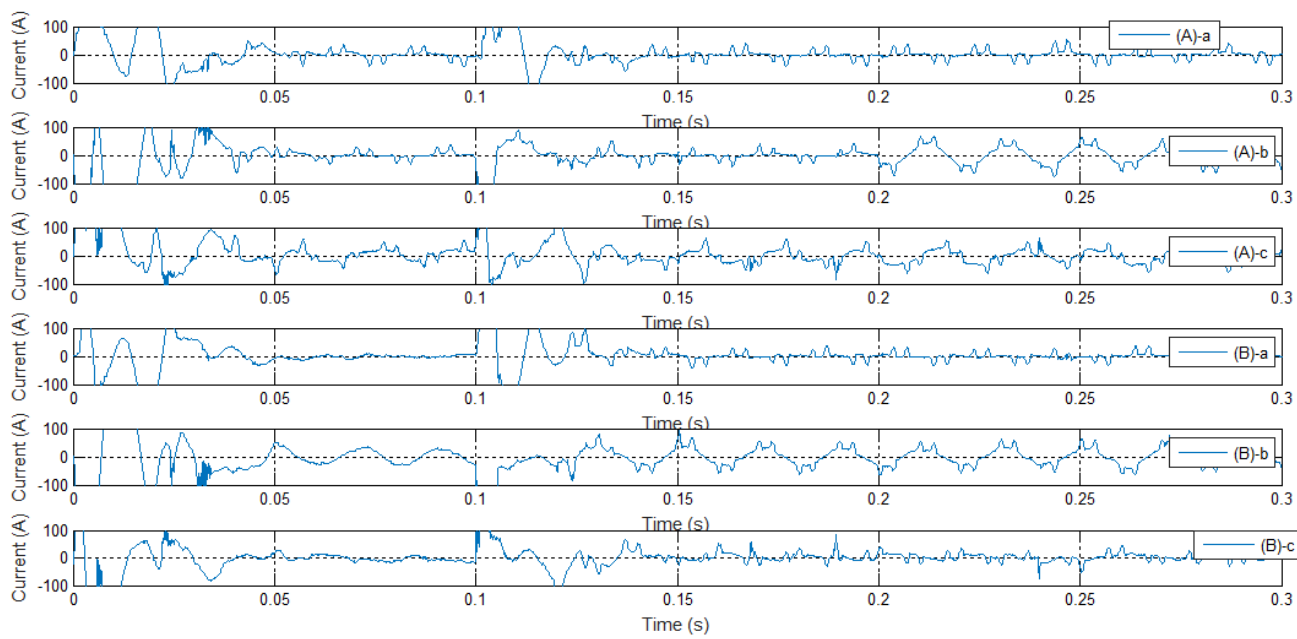
Figure 12. Current per phase and microgrid in mode interconnected and grid-islanded.